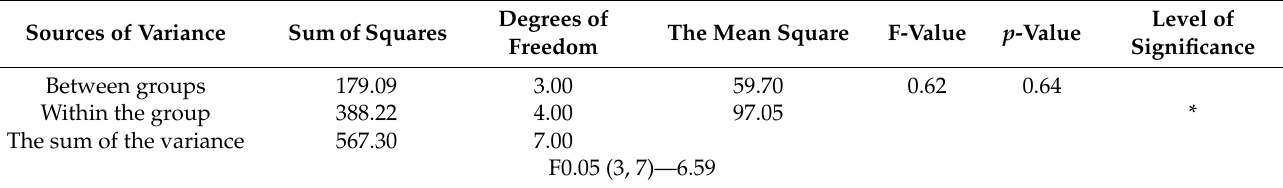
Table 6. Analysis of variance of concrete 7 − day compressive strength.